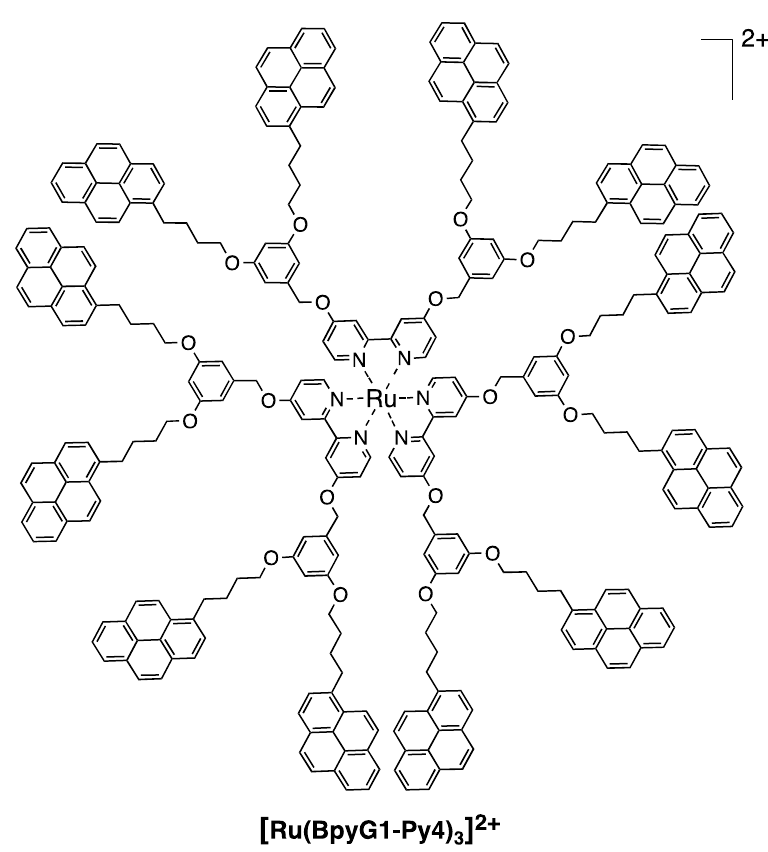
Figure 11. Structure of the dendritic ruthenium bipyridine complex possessing 12 pyrene units [49].